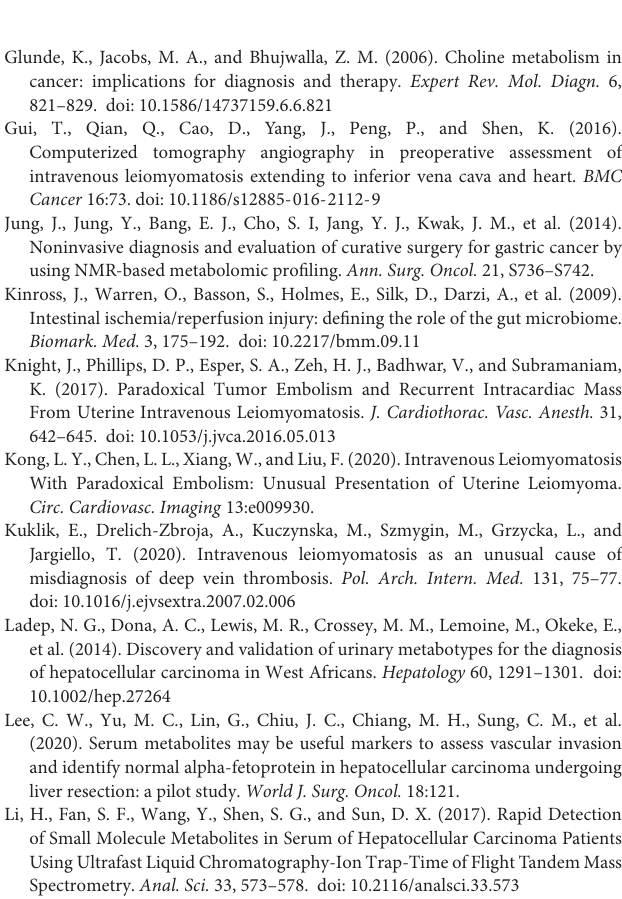
Supplementary Figure 1 | Quality control analysis of the project. (A,B) Total ion chromatogram of all samples along with quality controls in positive and negative modes, respectively. The abscissa represented the retention time of each chromatographic peak, and the ordinate represented the peak intensity. (C,D) Principal component analysis of all samples PCA in the positive and negative modes,